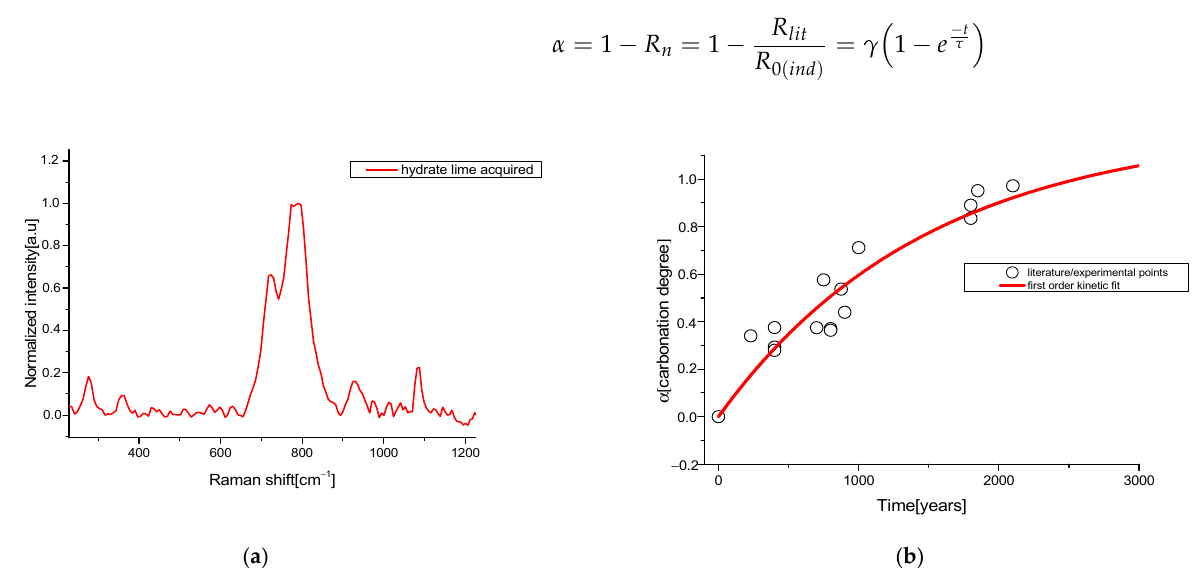
Figure 3. ( a ) 1064 nm—Raman spectrum of calcium hydroxide acquired; traces of calcite are present; ( b ) first order kinetics applied on data taken from literature and experimental data.